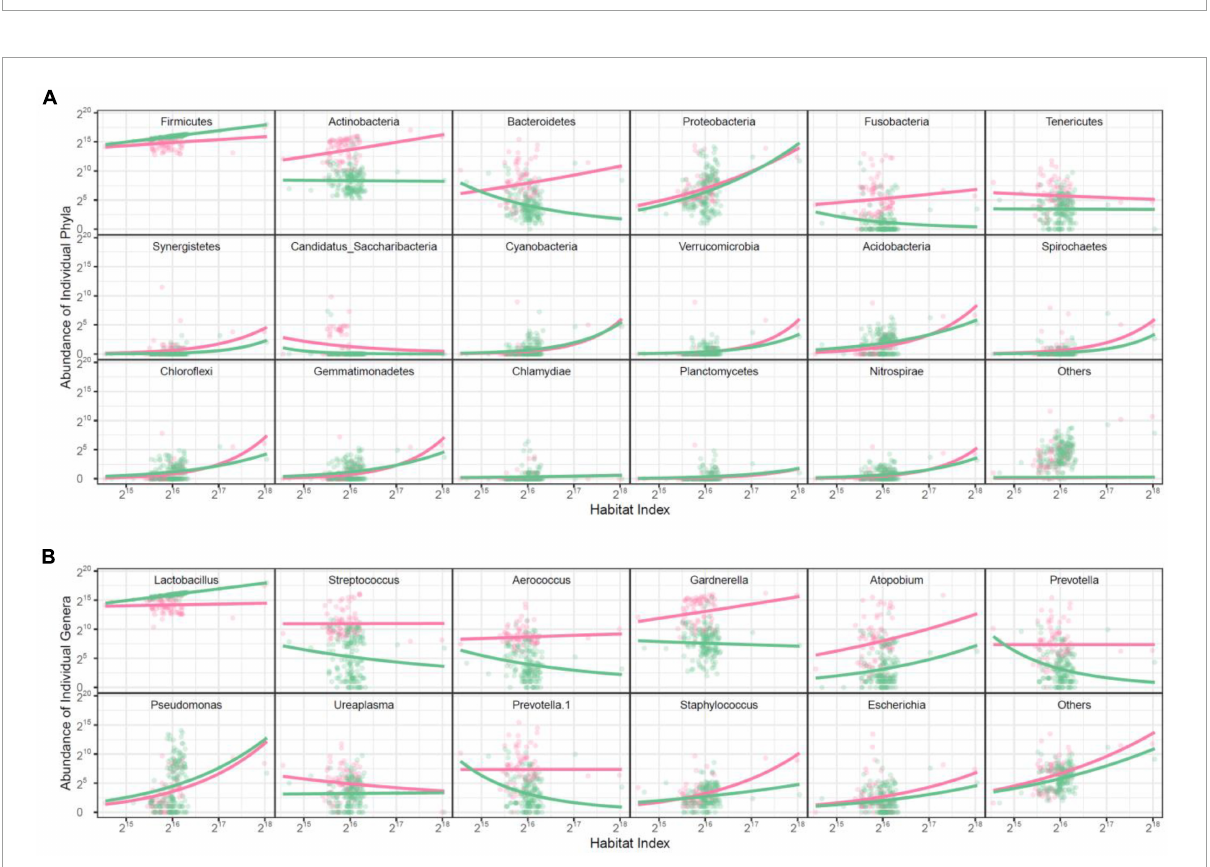
FIGURE2 Scatterplots of abundance of individual microbes against habitat index. The change of bacterial abundance is expressed at the phylum level (A) and the genus level (B) . Dots represent a phylum or genus, whose HI-varying abundance change is fitted by the power equation. Red color for The AV group is represented in red while the healthy group is in